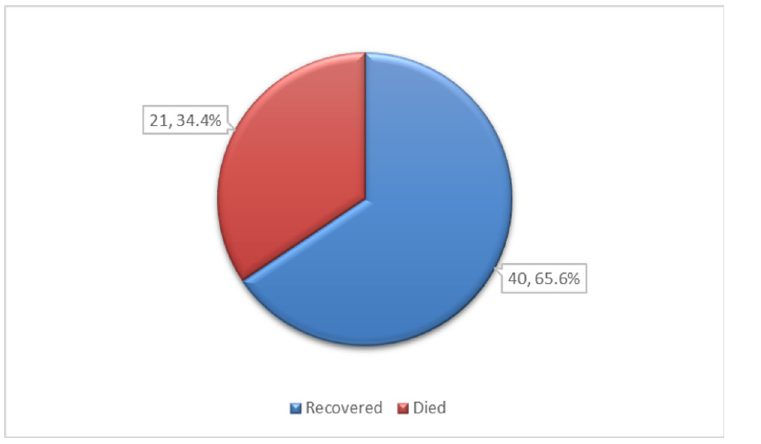
Fig 1. In-hospital mortality of tetanus patients (n =